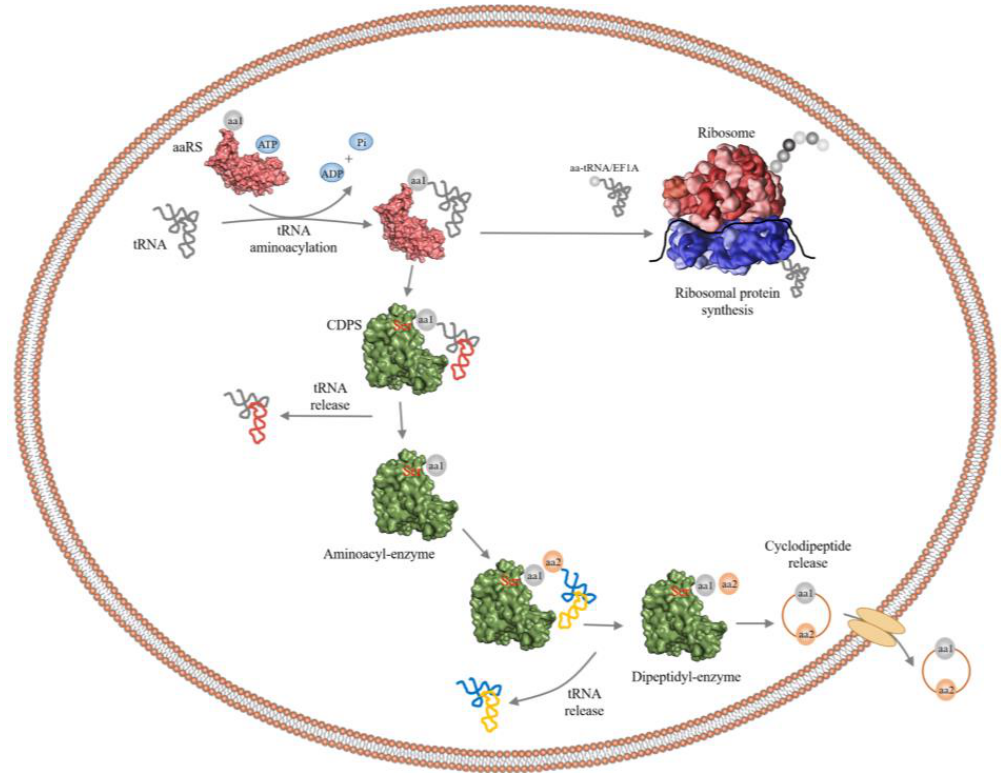
Figure 4. The overall catalytic mechanism of AlbC to produce cyclic dipeptides [21,38]. AlbC (green) uses two aa-tRNAs produced by aaRSs (light red) and is mainly involved in protein synthesis in the ribosome (red with blue). AlbC proceeds through a sequential mechanism that involves the formation of aminoacyl and dipeptidyl enzymes.